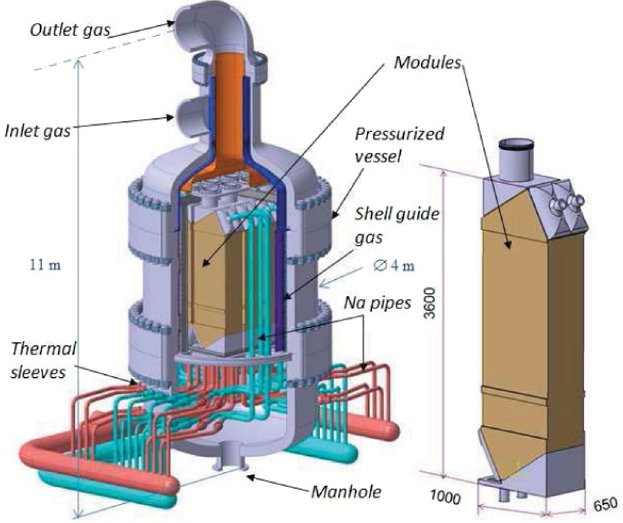
Fig. 4. Sodium-gas heat exchanger concept in